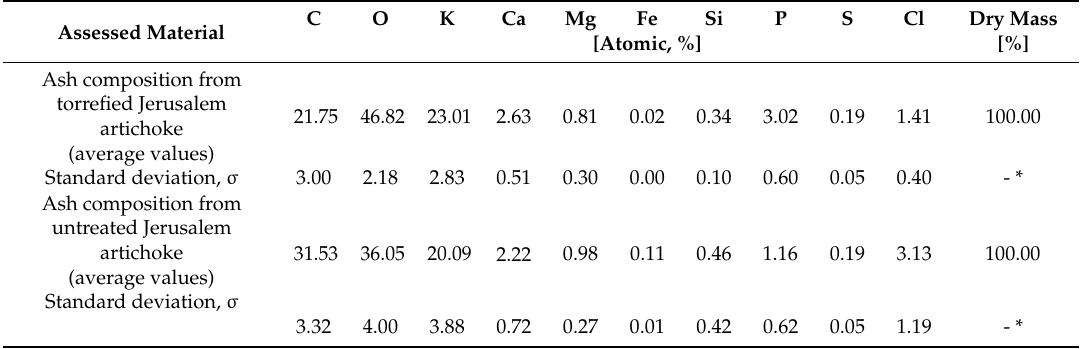
Table 4. Content of elements in the ash from untreated Jerusalem artichoke and torrefied Jerusalem artichoke burnt biomass.